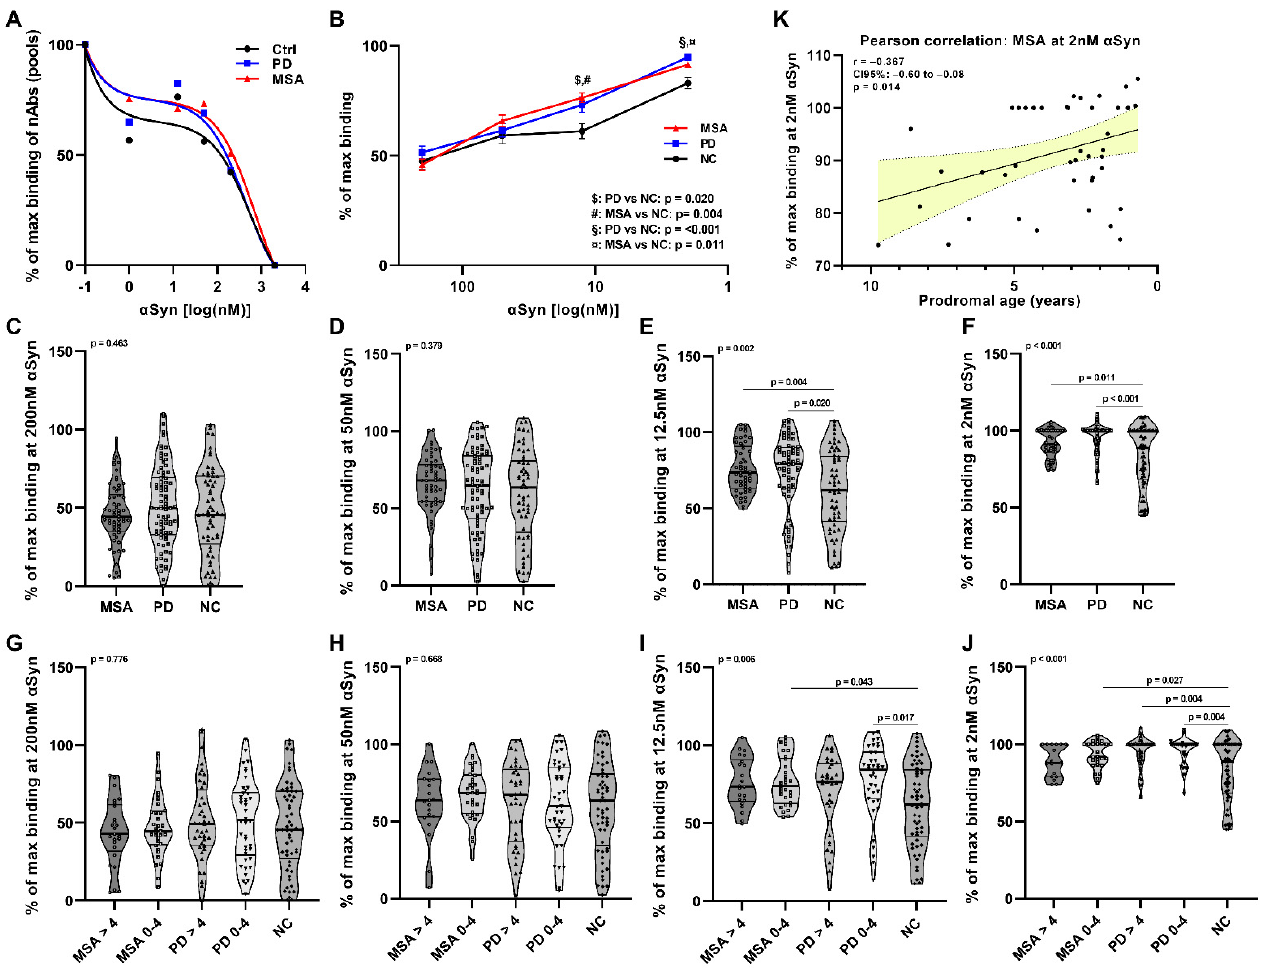
Figure 1. Serum anti- α Syn nAb affinity profiles. ( A ) A two-site inhibition curve profiles of pooled plasma samples from 10 age- and sex-matched serum samples from prodromal (p)MSA ( red triangles and line ), pPD ( blue squares and line ), and controls ( black circles and line ). Binding profiles of anti- α Syn nAbs in individual pMSA ( n = 59), pPD ( n = 82) and control ( n = 67) serum samples are summarized in ( B ). Binding of serum anti- α Syn Nabs to immobilized α Syn monomers in competitive immunoassay in the presence of ( C ) 200 nM, ( D ) 50 nM, ( E ) 12.5 nM, and ( F ) 2 nM free α Syn. ( G – J ) shows the data from (C–F) for individual serum samples from pMSA and pPD divided into two prodromal age stages (0–4 years and > 4 years prior to diagnosis), Pearson’s correlation of prodromal age, and the high-affinity nAbs at 2 nM in pMSA patients ( K ). All data are presented as “% of max binding” of anti- α Syn nAbs calculated as described in Section 4.5. Differences between groups were tested using multiple linear regression modeling including age and sex as confounding variables. Graphs (C–J) are presented as truncated violin plots with median ( bold lines ) and 25% quantiles ( thin lines ).